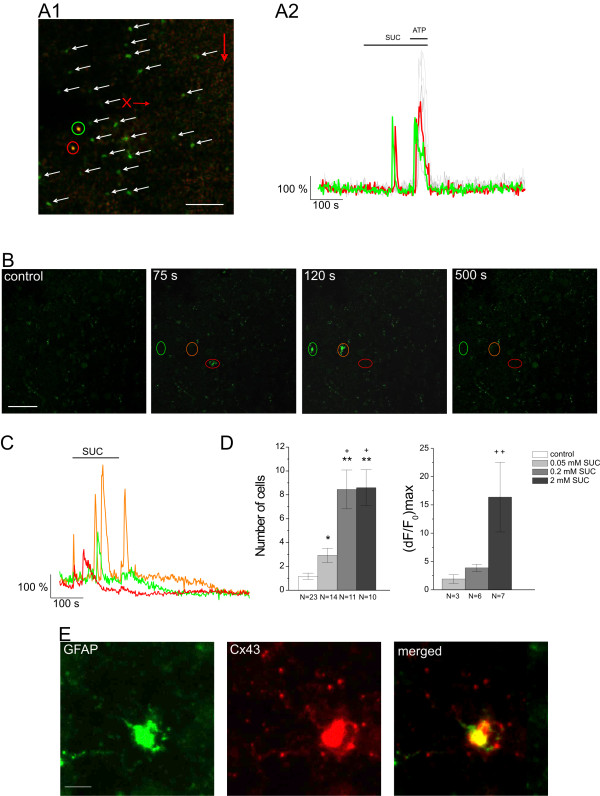
SUC and ATP evoke overlaying Ca2+ transients in NAc astrocytes. A1: Confocal image of SUC-responsive cells (green and red circled yellow spots) participated in ATP-stimulated concerted Ca2+ burst (green spots marked by white arrows). Red arrows show directions of SUC (vertical) and ATP (horizontal with x) applications. Scale bar is 50 μm. A2: Representative (dF/F0)max plots showing effects of 50 μM SUC alone and with 100 μM ATP puff in A1. Red and green traces correspond to the SUC-responsive cells circled in A1 while gray traces show the fluorescence changes of cells marked by white arrows in A2. B: Confocal images showing fluorescence of 5 μM Fluo-4 AM loaded cells in NAc slices during control (left image), 50 μM SUC application (middle images) and washout (right image). Time refers to the fluorescence-time plot (C). Scale bar is 50 μm. C: (dF/F0)max plots showing Ca2+ transients in response to 50 μM SUC in the NAc slice. Each coloured trace corresponds to a Ca2+ transient circled in (B). D: Comparison of cell number- and fluorescence intensity-based summary plots of the effects of SUC on Ca2+ fluorescence in rat NAc slices. *p < 0.05 and **p < 0.01 compared to control, +p < 0.05 and ++p < 0.01 compared to 50 μM (Mann-Whitney with Bonferroni post hoc tests; [3]). E: SUC-responsive repetitive Ca2+ transients co-localized with astroglial markers. The NAc slice showing SUC-responsive repetitive Ca2+ transients was subsequently double-immunostained for astroglial marker proteins GFAP (green, left) and Cx43 (red, middle) while the observation chamber kept continuously on the stage of the confocal microscope. Our post-Calcium protocol (cf. Methods section) showed yellow co-localisation of Cx43 and GFAP proteins (right) with a SUC-responsive cell shown in A. Scale bar is 5 μm.